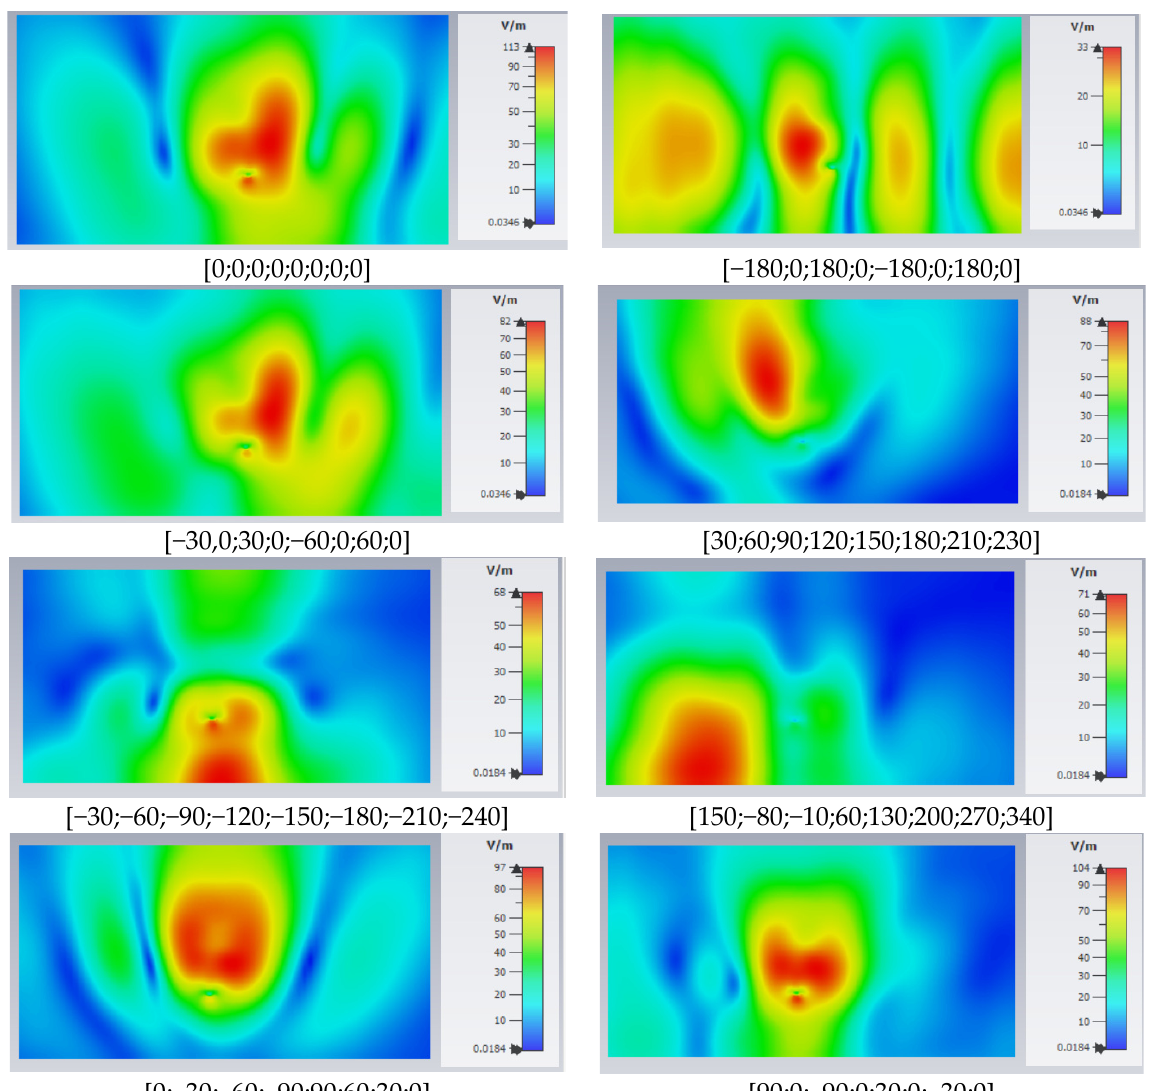
Figure 6. E-field strength in a receiving plane parallel to the 2 × 4 planar array antenna at 20 cm away (tangent to the face of the head model) as a function of the phase difference/beam steering direction.